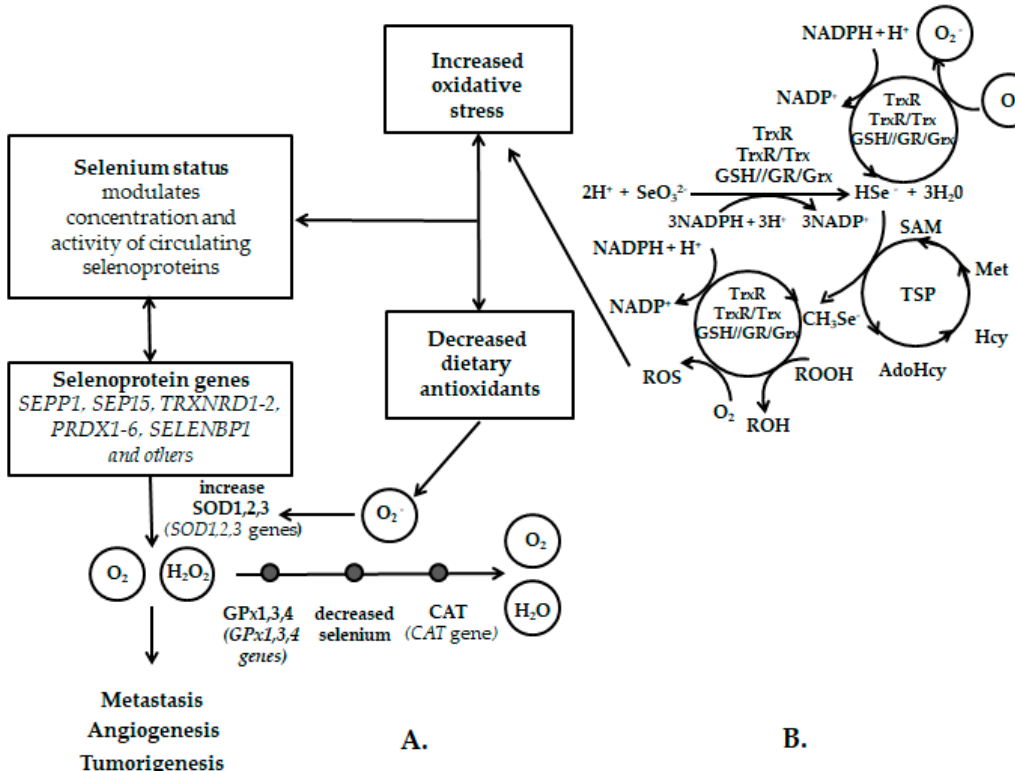
Figure 2. Biochemical and molecular biological scheme of selenium action (adapted from [139,140])—( A ) Involvement of selenoprotein genes in the antioxidant metabolic pathway with modification of the selenium effect on the risk of carcinogenic process; ( B ) Spontaneous methylation of selenide to methylselenol. SEPP1 —selenoprotein P gene; SEP15 —selenoprotein 15 gene; TRXNRD1–2 —